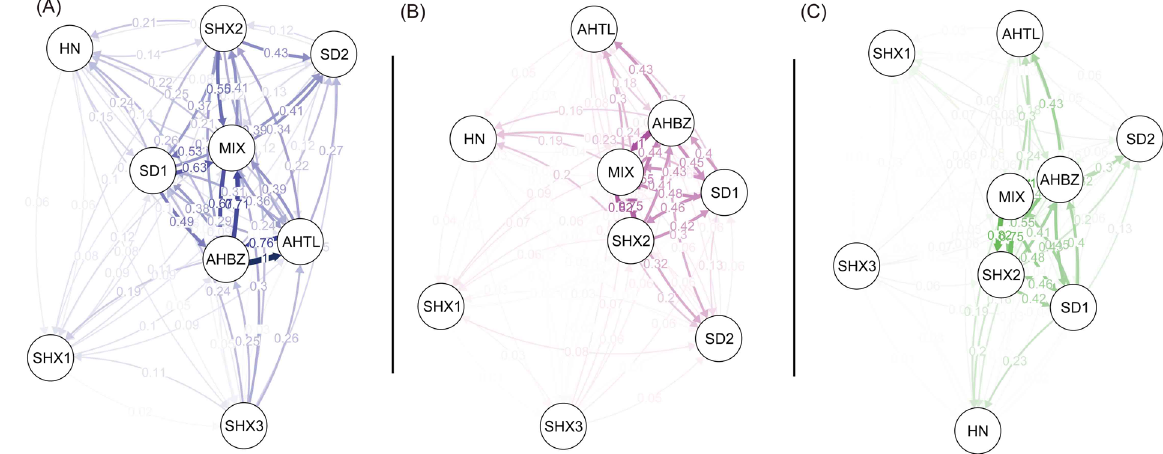
Figure 4. Directional relative migration networks of clustered samples from divMigrates. ( A ) Jost’s D values, ( B ) G ST values and ( C ) N m